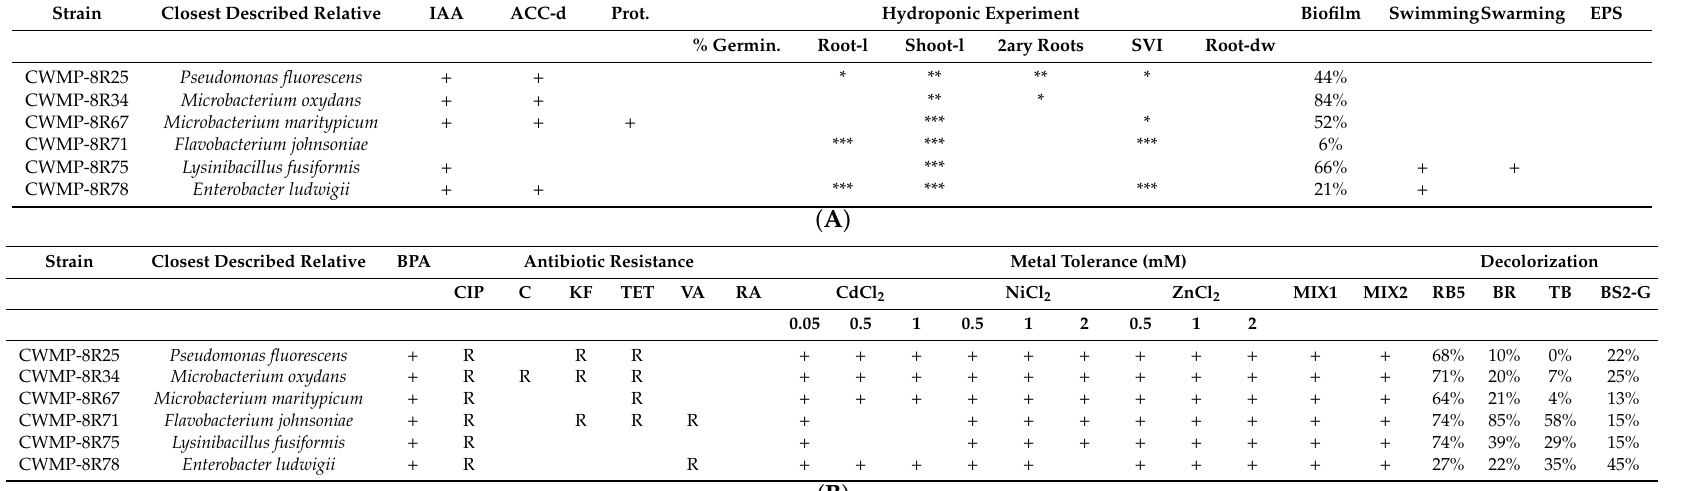
Table 1. Characterization of the six most promising bacteria used as inoculants in CW microcosm-scale experiment. ( A ) In vitro plant growth promotion (PGP) tests: IAA = IAA production; ACC-d = ACC deaminase activity; Prot. = protease production. In vivo PGP test under hydroponic condition with L. esculentum plants: % germin. = germination percentage; root-l = root length; shoot-l = shoot length; 2ary roots = production of secondary roots; SVI = seedling vigor index; root dw = root dry weight. Ability to bind the root apparatus: Biofilm = colorimetric assay for biofilm formation using E. coli ATCC25404 as positive control; Swimming = swimming lifestyle; Swarming = swarming lifestyle; EPS exopolysaccharides release. ( B ) BPA tolerance. Antibiotic resistance to CIP = ciprofloxacin; C = chloramphenicol; KF = cephalotin; TET = tetracycline; VA = vancomycin; RA = rifampicin. Metal tolerance to: CdCl 2 0.05, 0.5 and 1 mM; NiCl 2 0.5, 1 and 2 mM; ZnCl 2 0.5, 1 and 2 mM; MIX1 = ZnCl 2 30 µ M, NiCl 2 1.7 µ M and CdCl 2 0.1 µ M; MIX2 = ZnCl 2 150 µ M, NiCl 2 8.5 µ M and CdCl 2 0.5 µ M. In vitro decolorization ability of RB5 = reactive